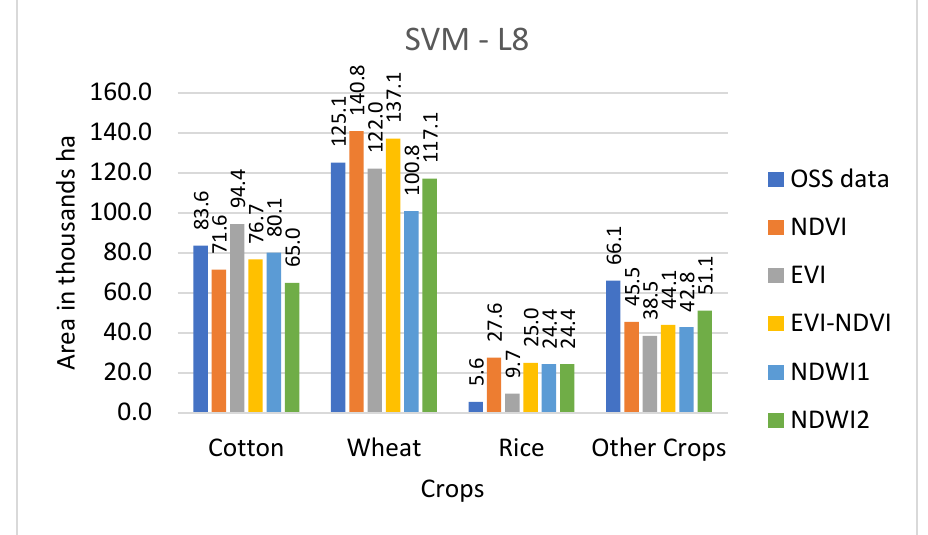
Figure 8. Comparison of classified crop types area with OSS data for SVM classifier with L8 sensor.